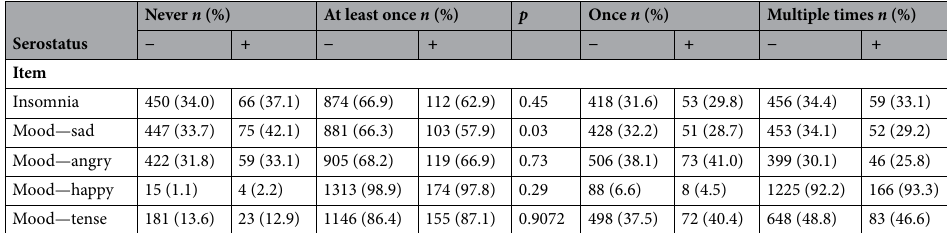
Table 2. Insomnia and mood results of seronegative (−) and seropositive ( +) participants to the Long- COVID19-survey ( n (%); Fisher’s exact test: n =